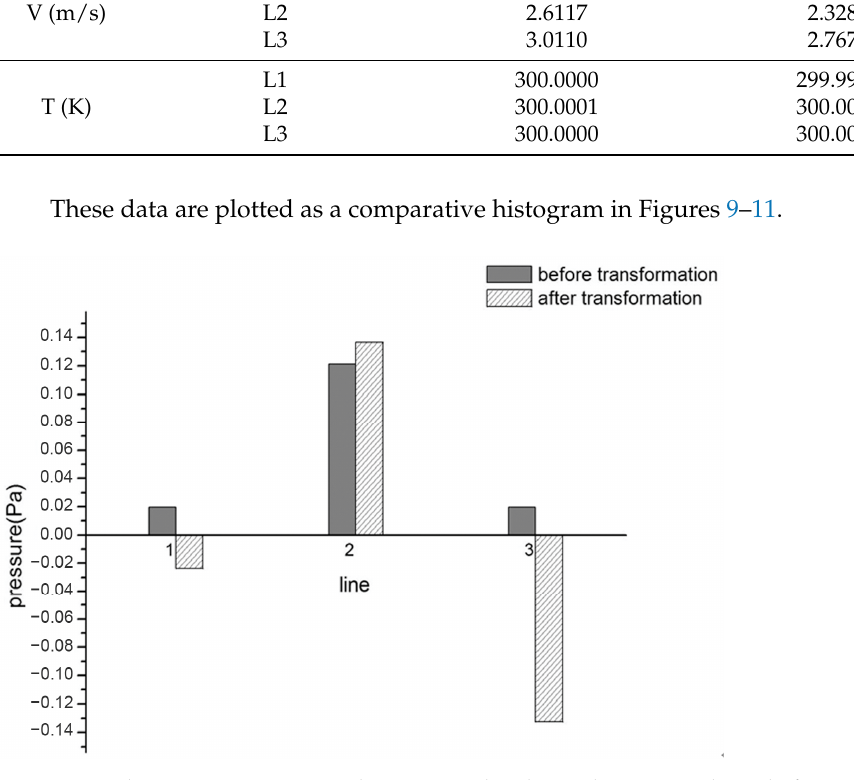
Figure 9. The average pressure changes on the three observation lines before and after the planned transformation.